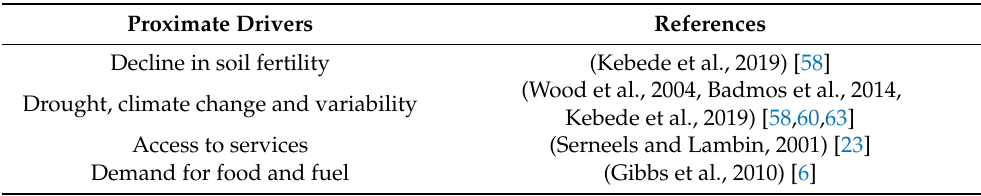
Table 3. Proximate drivers of agricultural